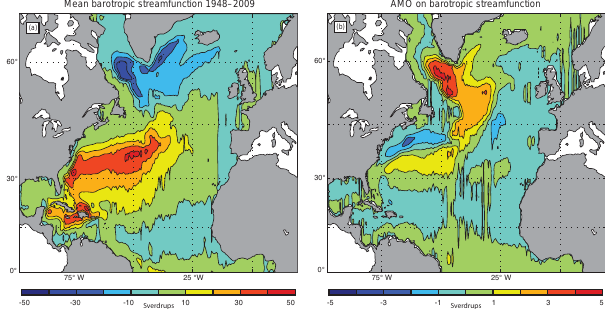
Figure 7. (a) 1948–2009 mean barotropic stream function and (b) AMO regressed onto barotropic stream function anoma- lies. Positive values denote clockwise motion. Units: sverdrups (1Sv = 10 6 m 3 × s − 1 )